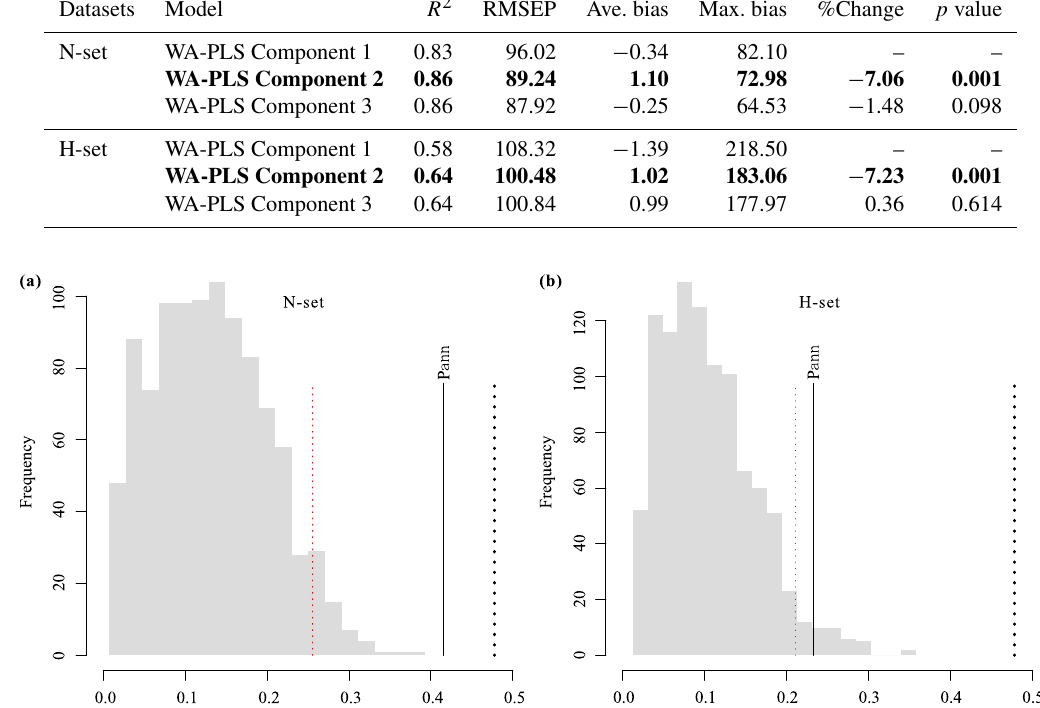
Table 2. Summary performance statistics of the first three components of the weighted averaging partial least squares regression (WA- PLS) for annual precipitation ( P ann ) based on leave-one-out cross validation for the natural set (N-set) and the human-induced set (H-set). Coefficient of determination between predicted and observed P ann ( R 2 ), root mean square error of prediction (RMSEP; mm), average bias (ave. bias) and maximum bias (max. bias), RMSEP change in percentage (%Change), and p value are given. The selected models are shown in bold.